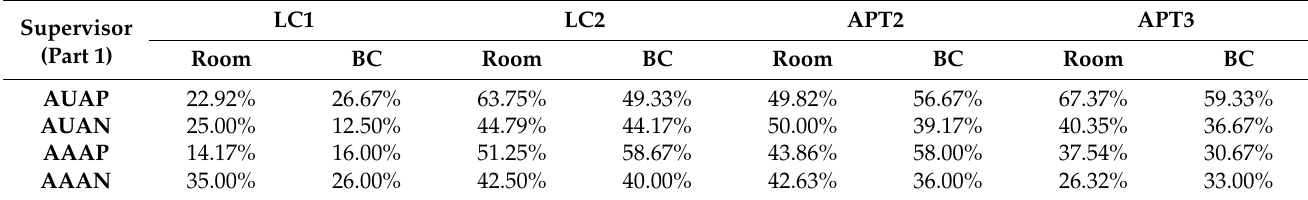
Table 12. Affordance presence for each design component in LC and APT projects reviewed by the supervisor (Part